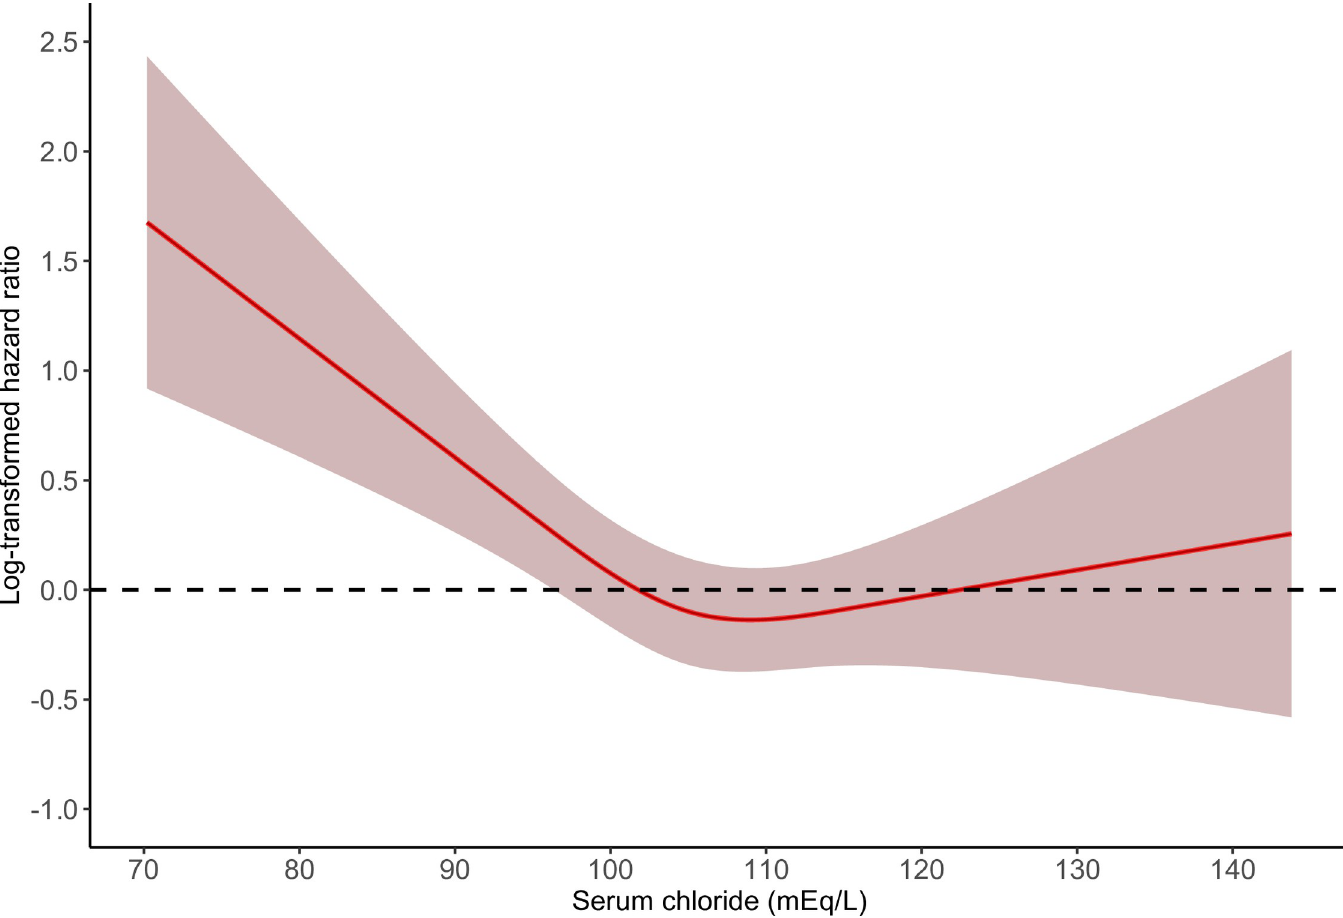
Fig 3. The smoothing curves of ICU mortality of critically ill AKI patients against serum chloride. The solid red lines represent the effect estimates and the shaded area represents 95% confidence intervals. P for non–linearity = 0.0015. Abbreviations: AKI, acute kidney injury; ICU, intensive care units.